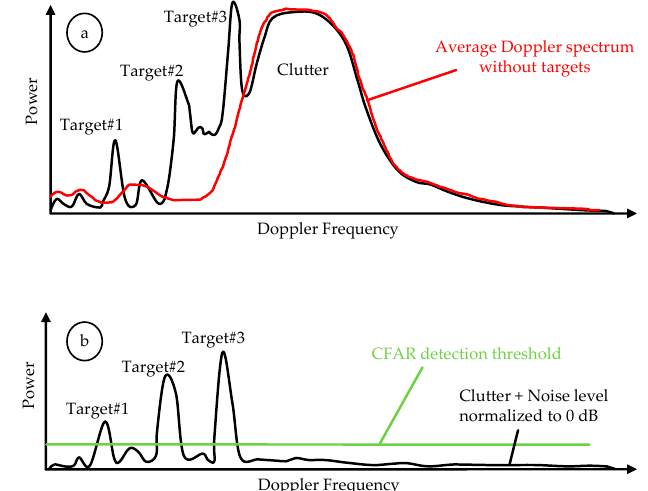
Figure 2. Illustration of the average Doppler spectrum of a range-Doppler image containing clutter and ship targets ( a ) before and ( b ) after normalization over Doppler. The red curve in ( a ) is the average Doppler profile estimated without considering the targets. The green line in ( b ) is the detection threshold computed based on clutter plus noise level.